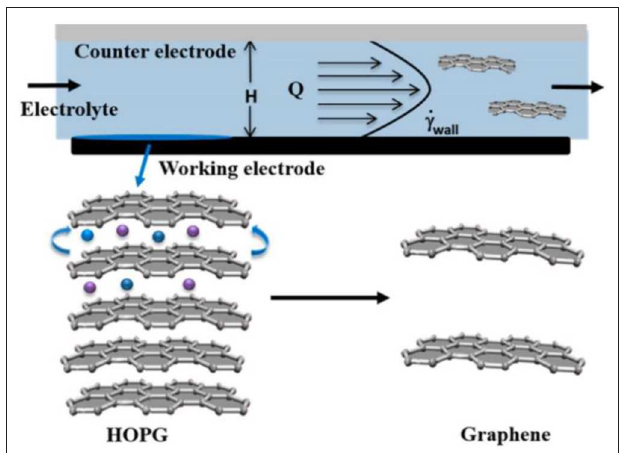
FIGURE 4 | Schematic of the experimental principle of an electrochemical microreactor. Graphite crystals were both reactor walls and working electrodes that apply an electric field at the same time as high shear. H , Q , and γ are the height between the two electrodes, the electrolyte flow rate, and the shear rate,